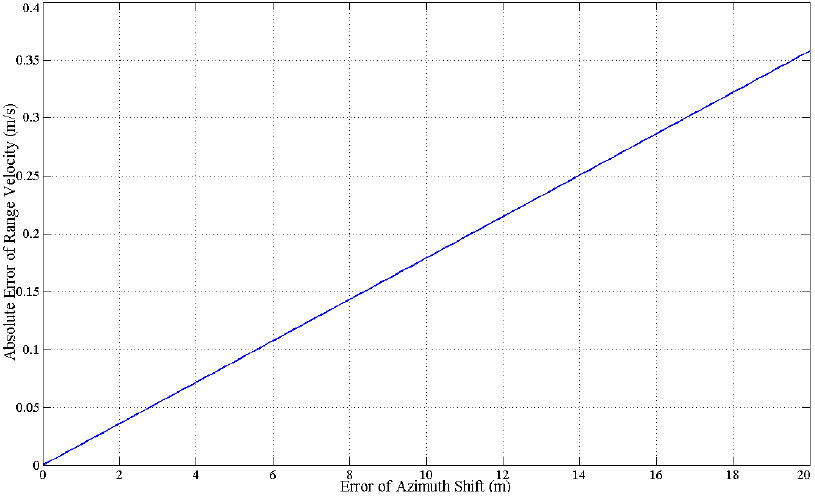
Figure 7. The absolute error of range velocity estimation versus the azimuth shift error.